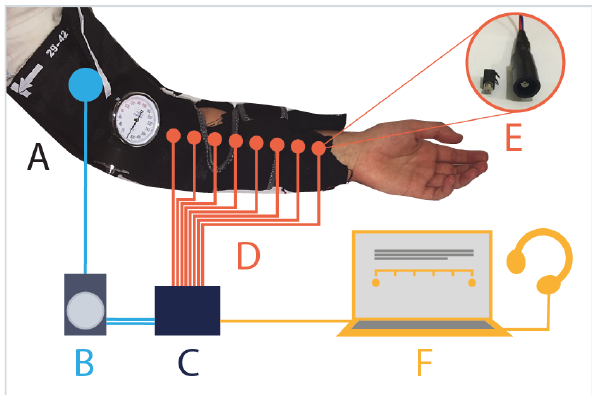
Figure 2. Pump-and-Vibe device and experimentAL setup for Experiment 2. A: Pump-and-Vibe interface worn by a participant. B: An air pump powers the Squeezer surrounding the upper arm. C: An Arduino controls the pump and motors. D: Eight vibration motors are arranged linearly along the forearm. E: Casings protect the motors and spread vibration. F: A laptop records participant responses and sends serial commands to the Arduino while simultaneously playing music stimuli via